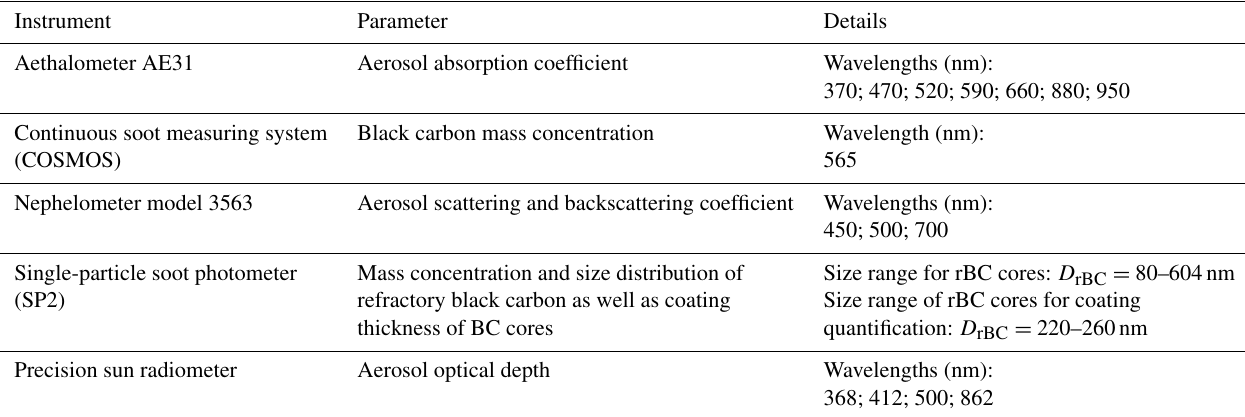
Table 1. List of instruments and measured